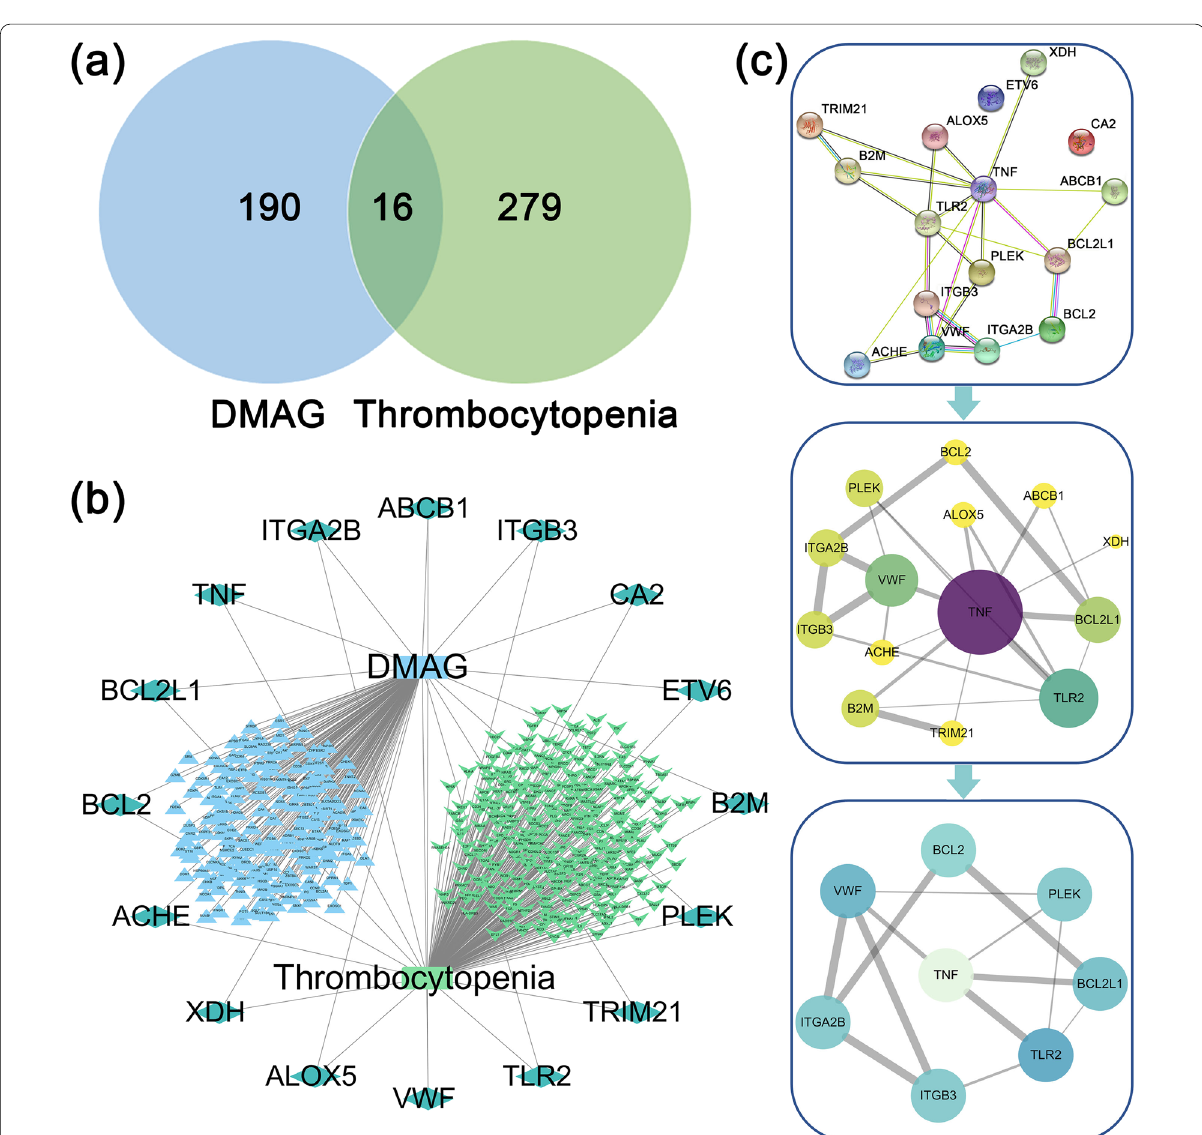
Fig. 4 Prediction of the targets of DMAG against thrombocytopenia by network pharmacology. a Venn diagram shows the common targets of DMAG and thrombocytopenia. Blue and green regions represent DMAG associated and thrombocytopenia associated targets, respectively. The intersecting part represents the common targets between DMAG and thrombocytopenia. b The DMAG‑targets‑thrombocytopenia network that was constructed by cytoscape_v3.7.1 software. c PPI network for identifying core targets of DMAG against thrombocytopenia through the screening conditions of Degree > 2, BC > 0.0042735, CC >